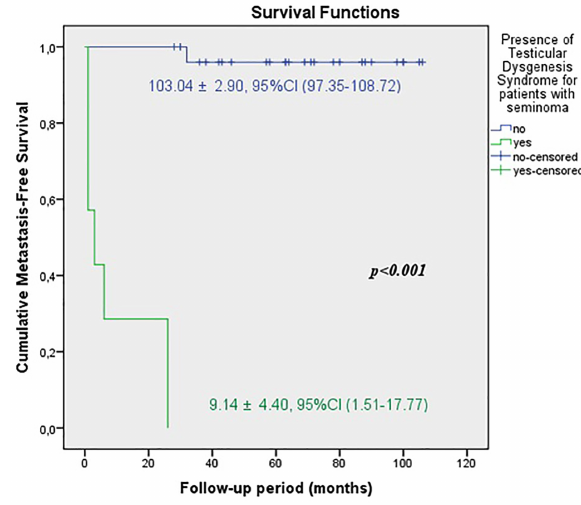
Figure 3B - Kaplan-Meier plots of metastasis-free survival according to presence of Testicular Dysgenesis Syndrome for patients with